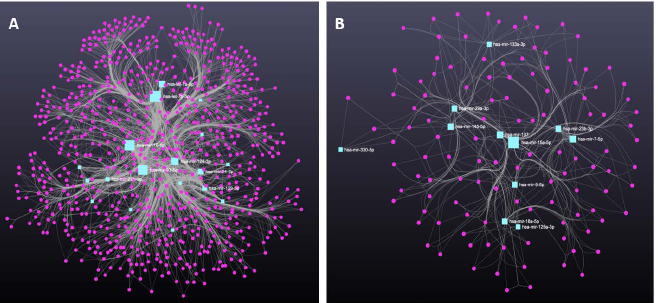
Figure 3. ( A ) Prediction-based miRNA-target association network using MDD-enriched miRNAs collected from the literature; ( B ) Prediction-based miRNA-target association network using BD enriched miRNAs collected from the